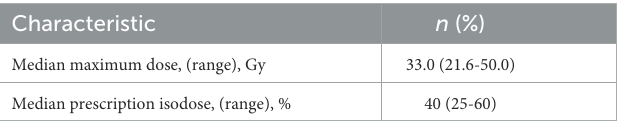
TABLE 2 GKRS treatment outcomes in the entire series.